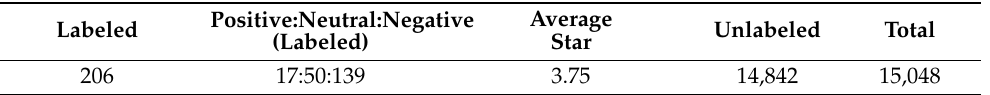
Table 4. Lifelong Fine-grained product review sentiment classification—Twitter (LFSC-T) dataset.